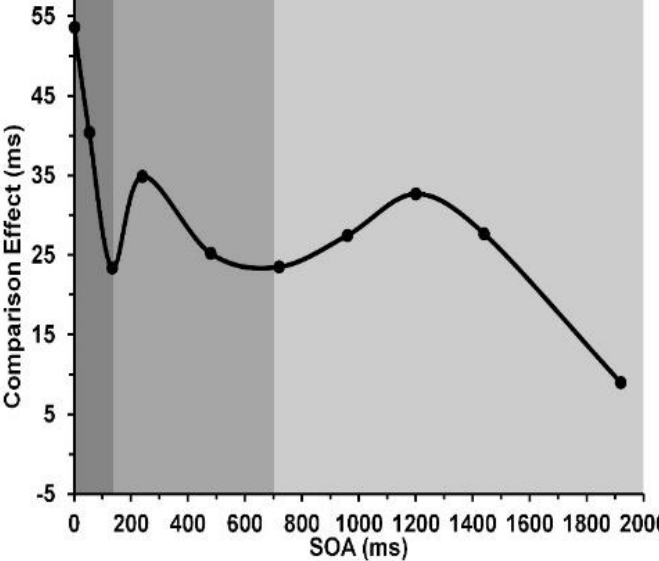
Figure 1. Comparison effect (RT probe mismatch— RT probe match ) as a function of prime–to–probe SOA. Reprinted from Jacob et al. [14], with permission © 2013, Springer Nature.